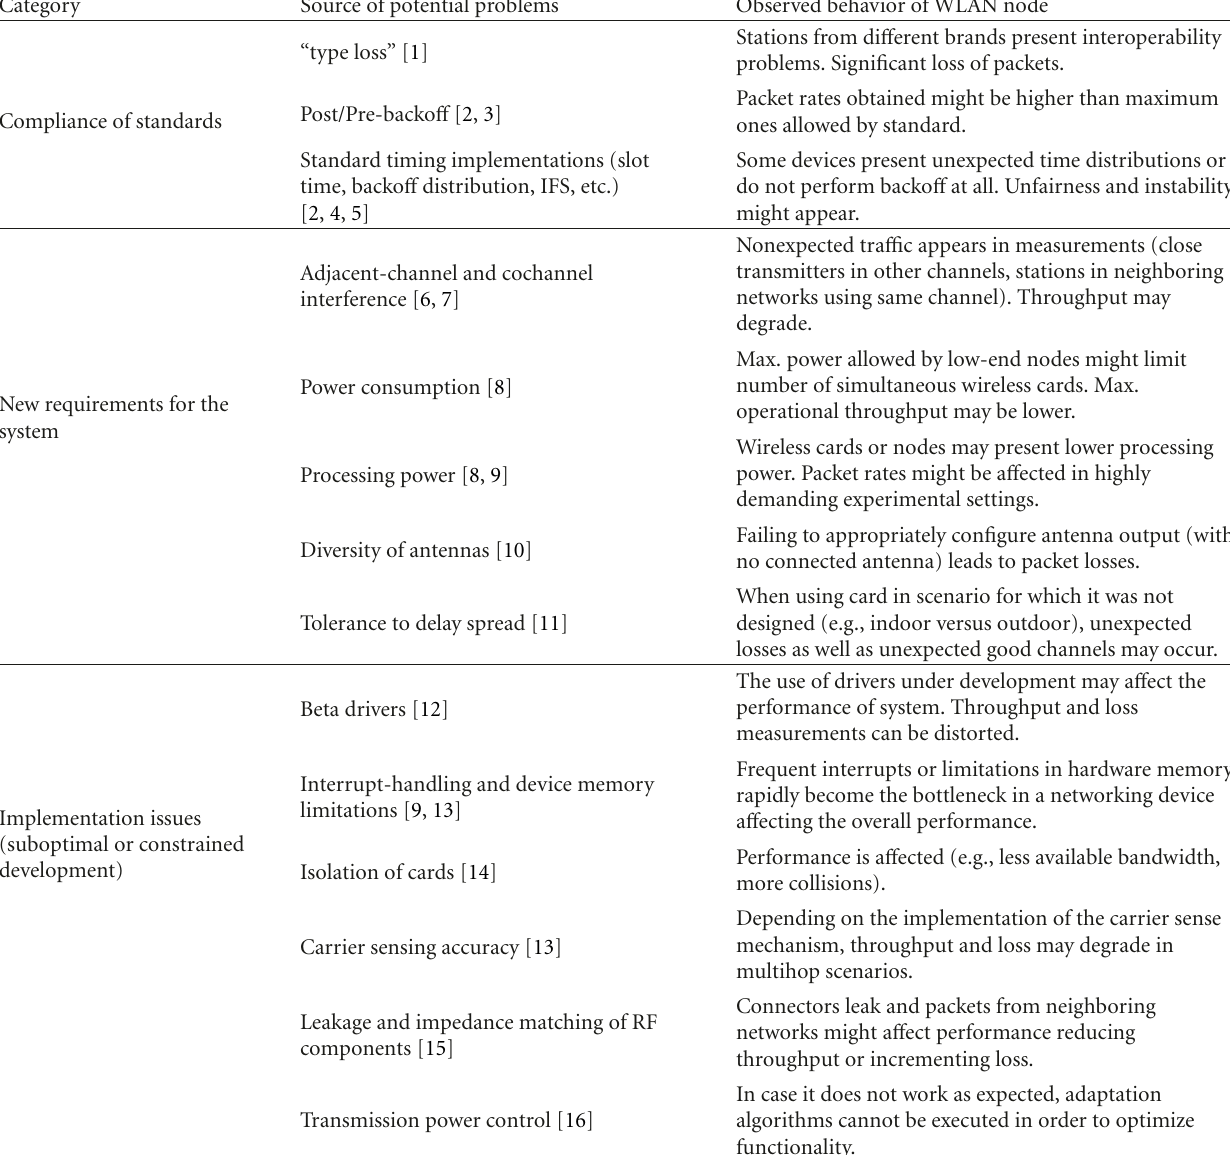
Table 1: Classification of the performance issues related to wireless networking: Origin and possible